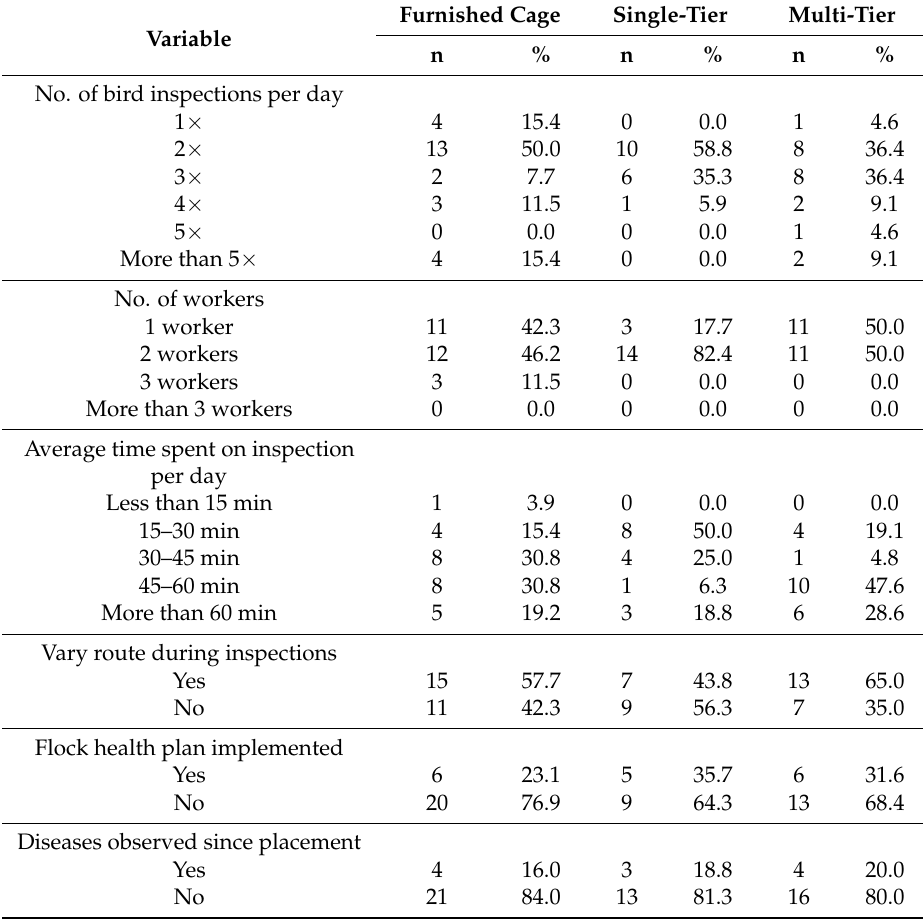
Table 8. Frequency of flock health management practices for 65 laying hen flocks placed between October 2016 and December 2017 according to housing system (furnished cage n = 26, single-tier n = 17, multi-tier n = 22) in